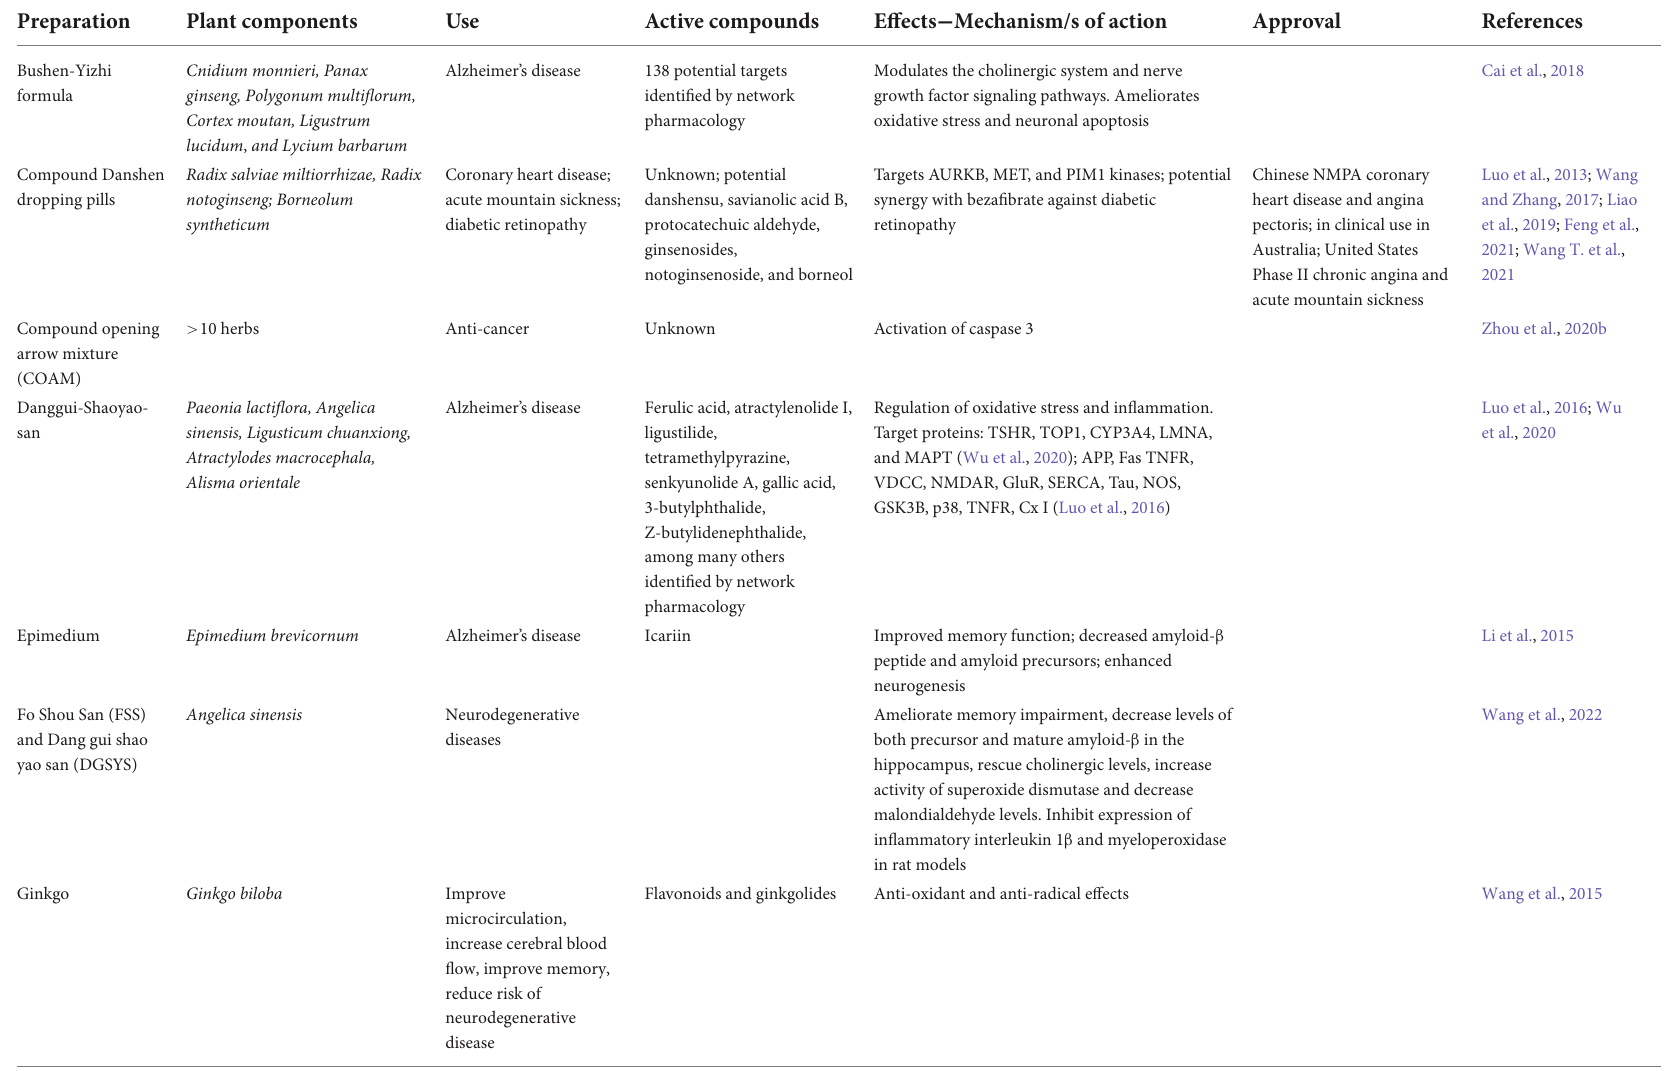
TABLE 1 Characteristics of main preparations described in the